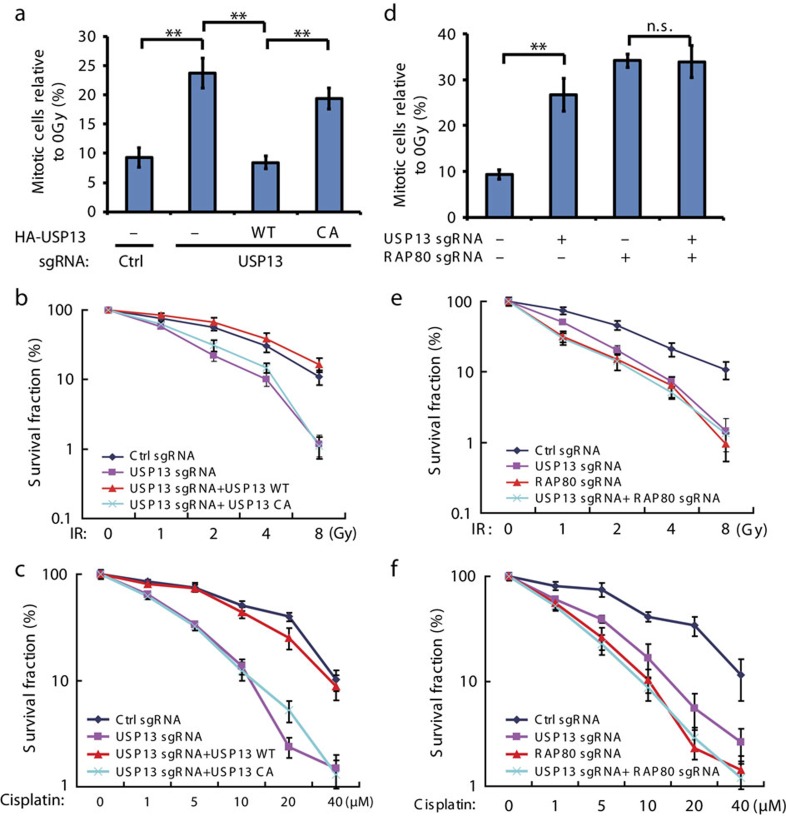
USP13 regulates DDR and radiosensitivity through RAP80.(a) Control, USP13 knockout, and USP13 knockout cells stably expressing the indicated constructs were left untreated or treated with IR (2 Gy). After a further 1 h, cells were collected, fixed and stained with anti-phospho-H3 antibodies to determine the mitotic population (mitotic index). (b-c) The sensitivity of the same cells as in a to IR (b) and cisplatin (c) were assessed using colony formation assay. (d) Control and USP13 knockout, RAP80 knockout or USP13 and RAP80 double-knockout cells were subjected to mitotic population determination as in a. (e–f) The sensitivity of cells the same as in d to IR (e) and cisplatin (f) were assessed using colony formation assay. (a-f) Error bars represent±s.e.m. from three independent experiments. **P<0.01. Statistical analyses were performed with the ANOVA. ANOVA, analysis of variance.